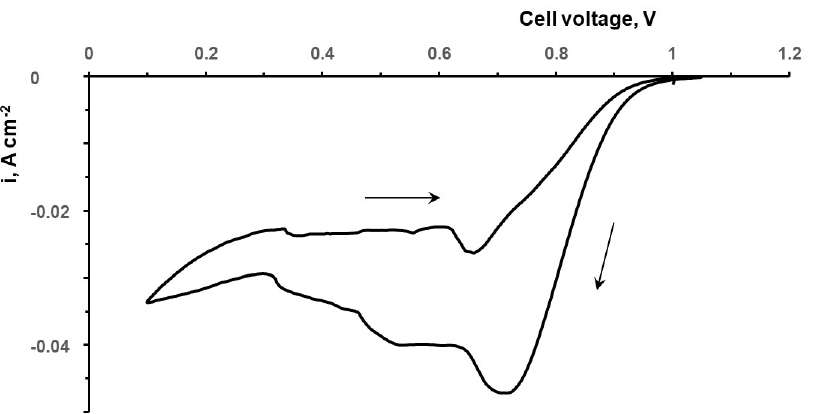
Figure 6. Voltammetry curve measured for the H 2 /iodate flow cell at 25 °C. The voltage scan was initiated at an open circuit voltage at a rate of 2 mV s − 1 . The 0.4 M KIO 3 -1 M H 2 SO 4 electrolyte was supplied at a rate of 0.1 mL min − 1 .